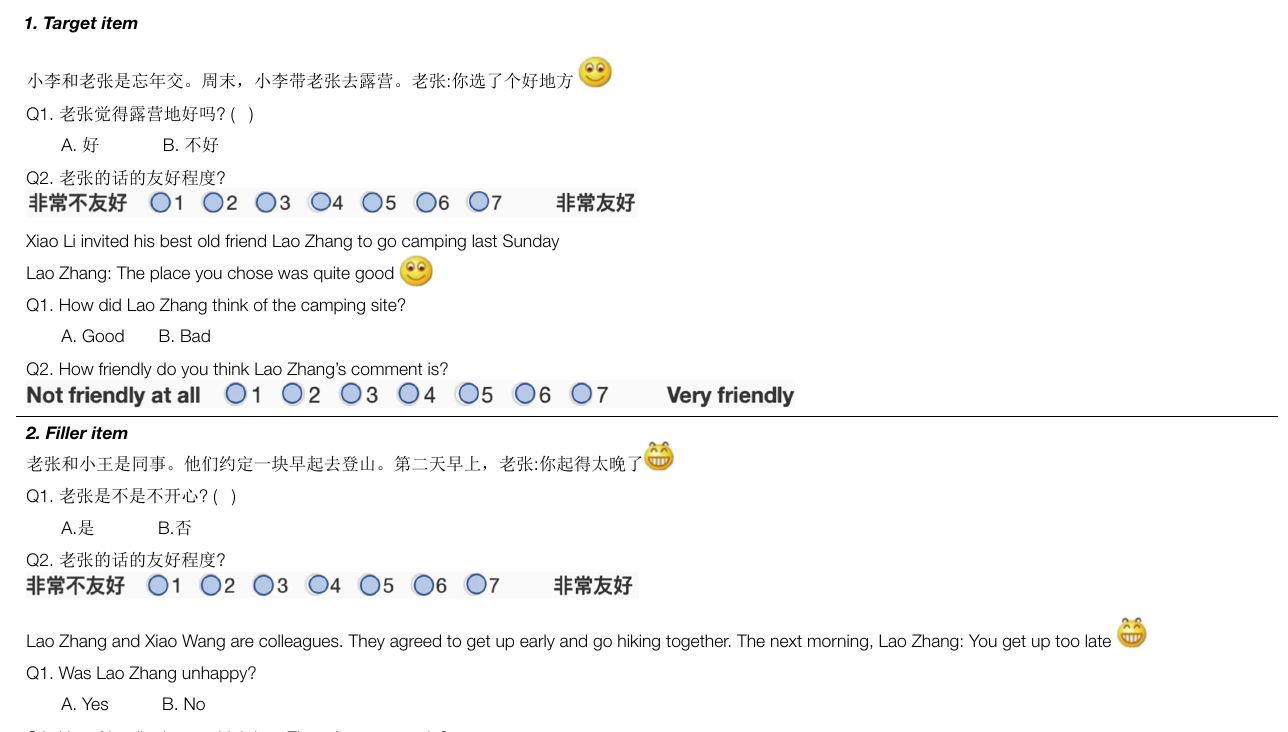
TABLE 1 | Example materials in Experiment